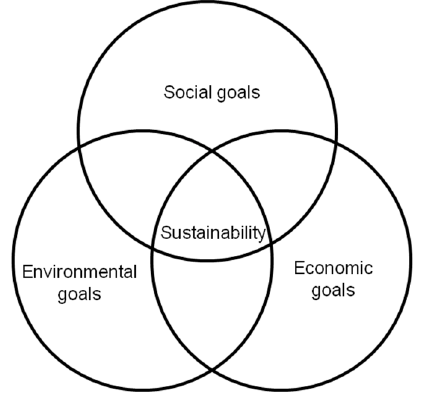
Figure 1. Triple bottom line (TBL) goal system.